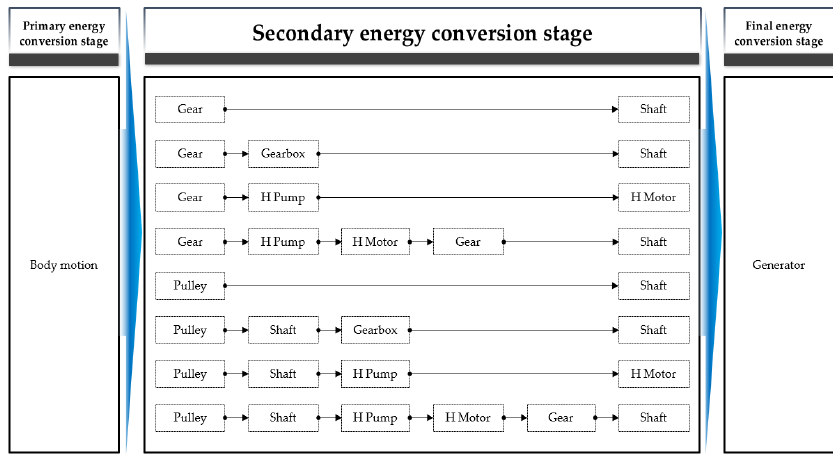
Figure 5. PFD of secondary energy conversion system started with the mechanical system.